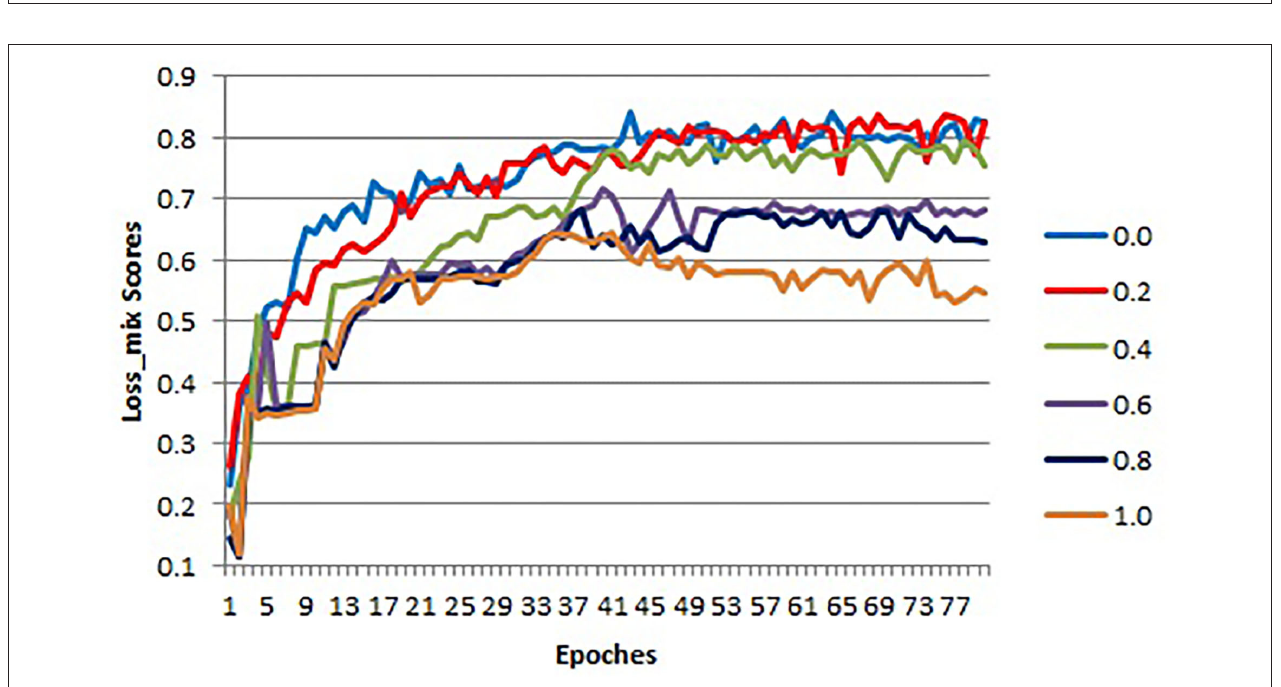
FIGURE 6 | The loss mix curves of verification samples for different λ values.